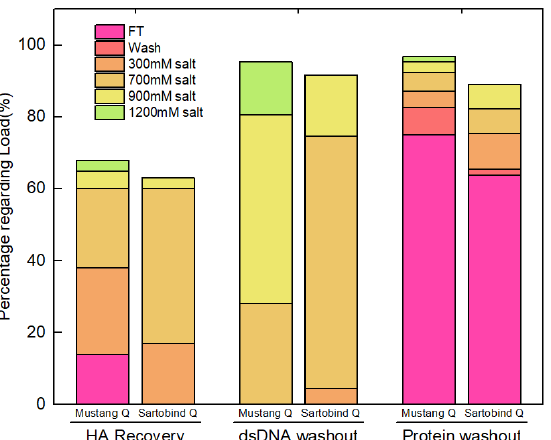
Figure 2. Assay results of chromatography for Mustang® Q and Sartobind® Q from Run #1. The percentages are calculated regarding loading material. Each fraction is shown with a different color. The first, second, and third two bars represent dsDNA, HA recovery, and proteins, respectively. Table 4. Different performance of Mustang ® Q and Sartobind ® Q in ion exchange chromatography step using the supernatant from Run #1.